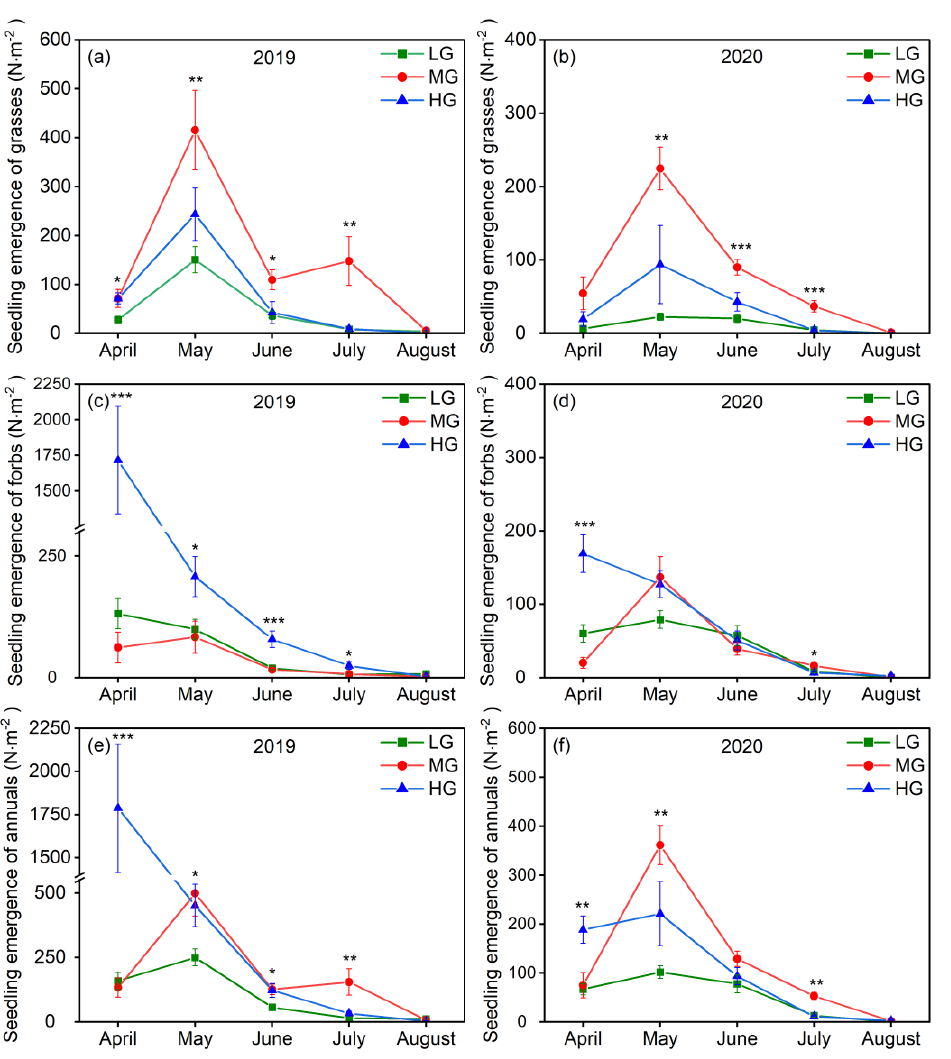
Figure 5. The monthly seedling emergence of different functional groups under the different grazing intensities during the two contrasting years. The asterisk indicates significant difference among grazing intensities each month. ( a , b ) the seedling emergence of grasses; ( c , d ) the seedling emergence of forbs; ( e , f ) the seedling emergence of all annuals. Mean ± SE. * p < 0.05, ** p < 0.01, *** p < 0.001.